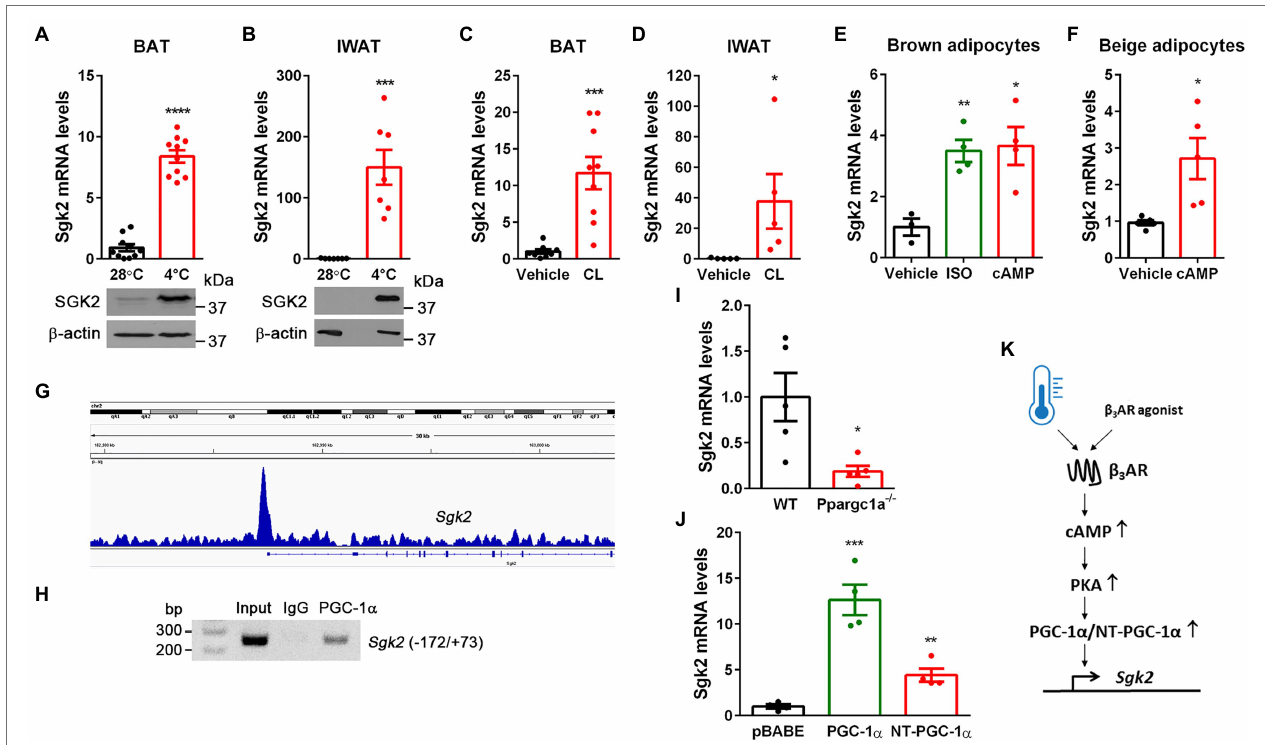
FIGURE 1 | Cold- and CL316243-dependent upregulation of Sgk2 gene expression is mediated by PGC-1 α and NT-PGC-1 α . (A) Effect of cold on Sgk2 mRNA and protein levels in BAT. 9-week-old BL6 female mice were housed at 28 ° C ( n = 10) or exposed to 4 ° C for 5 h ( n = 10). (B) Effect of cold on Sgk2 mRNA and protein levels in IWAT. 9-week-old BL6 female mice were housed at 28 ° C ( n = 7) or exposed to 4 ° C for 7 days ( n = 7). (C) Effect of β 3 AR stimulation on Sgk2 expression in BAT. 8-week-old BL6 male mice were administered with vehicle ( n = 8) or a β 3 AR agonist CL316243 ( n = 8) for 5 h. (D) Effect of β 3 AR stimulation on Sgk2 expression in IWAT. 8-week-old BL6 male mice were administered with vehicle ( n = 5) or CL316243 ( n = 5) for 7 days. (E) Upregulation of Sgk2 expression by a β AR agonist or cAMP in brown adipocytes. Differentiated brown adipocytes (7 days) were treated with vehicle, isoproterenol (5 μ M) or dibutyryl cAMP (0.5 mM) for 4 h ( n = 4 per group). (F) Upregulation of Sgk2 expression by cAMP in primary beige adipocytes. Differentiated beige adipocytes (7 days) were treated with vehicle or dibutyryl cAMP (0.5 mM) for 4 h ( n = 5 per group). (G) Enrichment of PGC-1 α /NT-PGC-1 α on the Sgk2 promoter in cold-activated BAT. The PGC-1 α /NT-PGC-1 α ChIP-seq peak (Chang et al., 2018) was visualized by the Integrative Genomics Viewer (IGV) v2.3. (H) PCR analysis of PGC-1 α /NT-PGC-1 α recruitment to the ERRE of the Sgk2 promoter. ChIP was carried out with PGC-1 α antibody (Chang et al., 2018) in nuclear extracts of BAT isolated from mice exposed to 4 ° C for 5 h. (I) Decreased induction of Sgk2 expression in Ppargc1a − / − brown adipocytes treated with dibutyryl cAMP ( n = 5 per group). (J) PGC-1 α - and NT-PGC-1 α -dependent upregulation of Sgk2 expression in Ppargc1a − / − brown adipocytes ( n = 4 per group). (K) Schematic presentation of transcriptional regulation of Sgk2 by cold or β 3 AR agonist. All data are presented as the mean ± SEM. * p < 0.05, ** p < 0.01, *** p < 0.001, **** p < 0.0001 determined by Student’s t